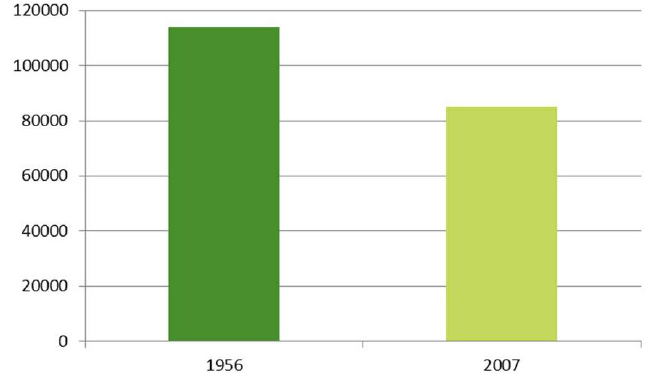
Figure 2: Changes in the area occupied by the dehesa.